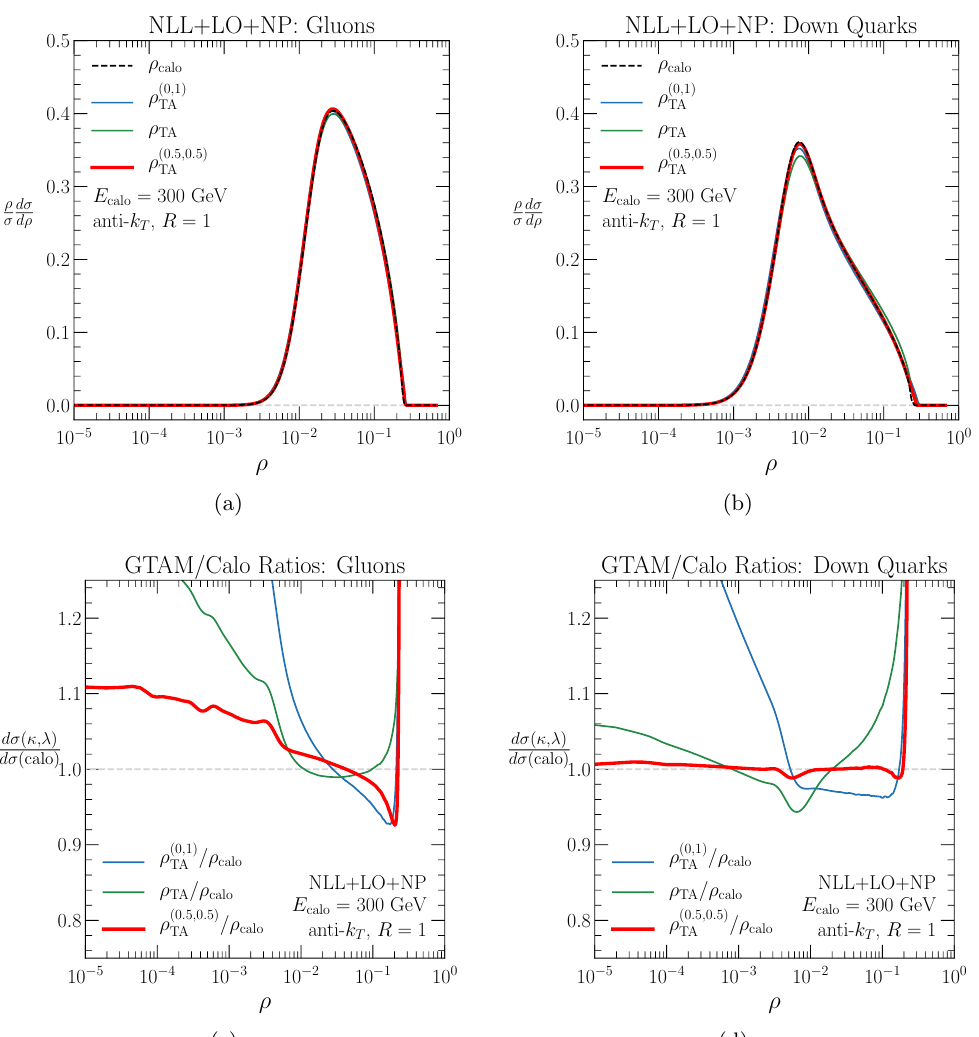
Figure 13 . Same as (cid:12)gure 11, but including the non-perturbative